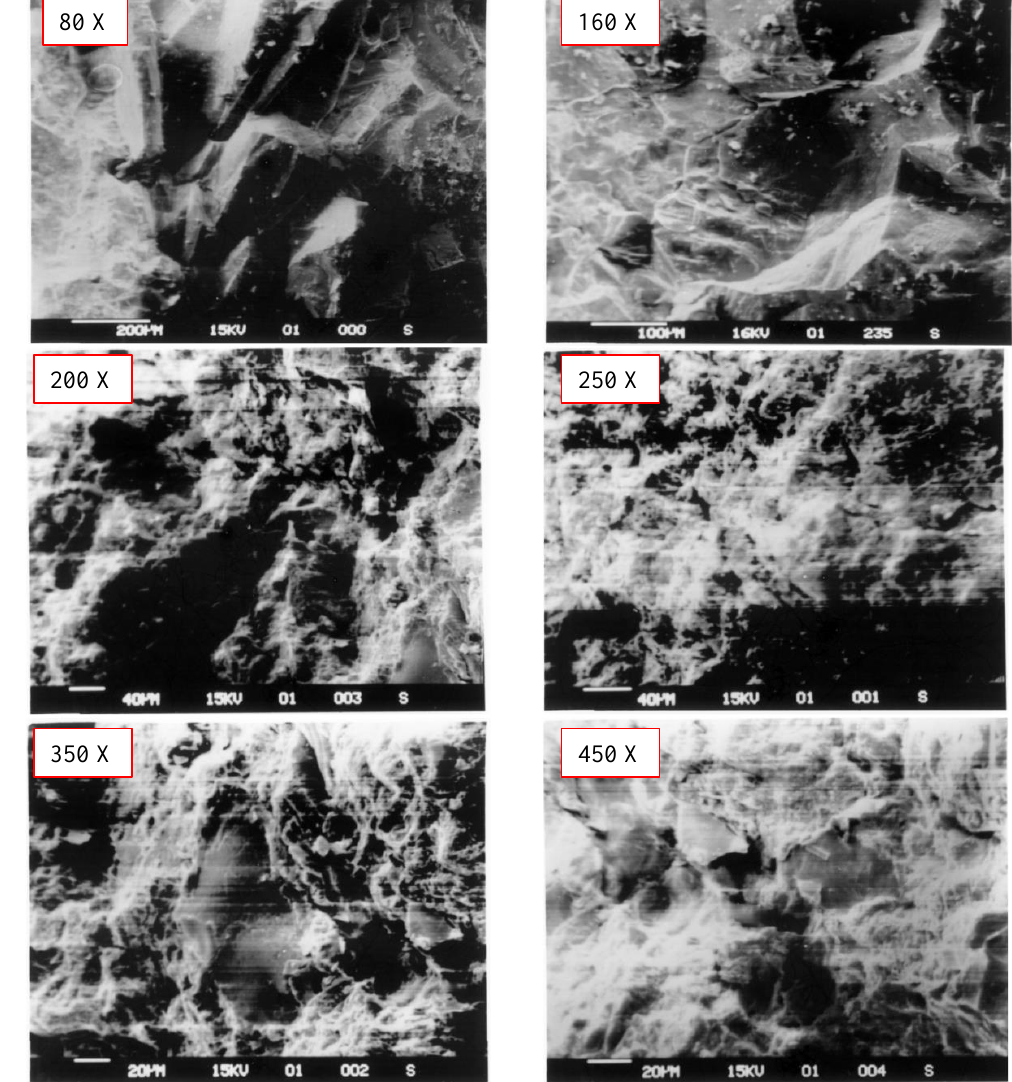
Figure 6. SEM images of CGBM under various magnification.